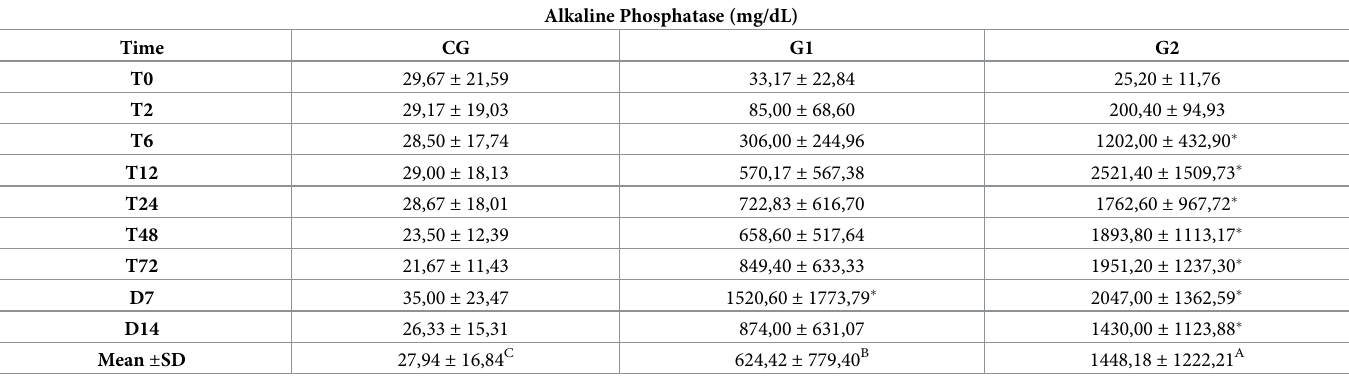
( � ) represent differences compared to baseline time (T0) within the group; Different capital letters represent differences between groups at the same time; p �